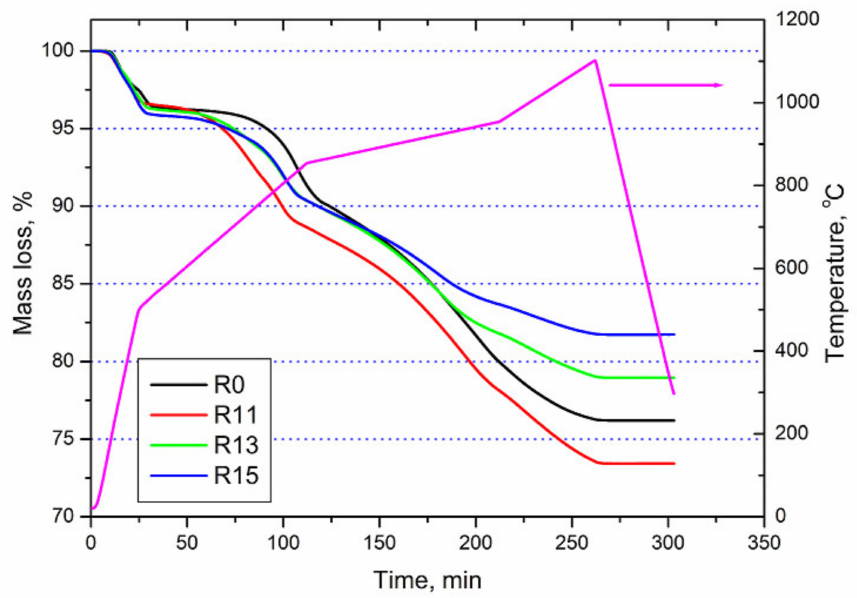
Figure 6. Mass loss curves of studied briquettes as a function of time and